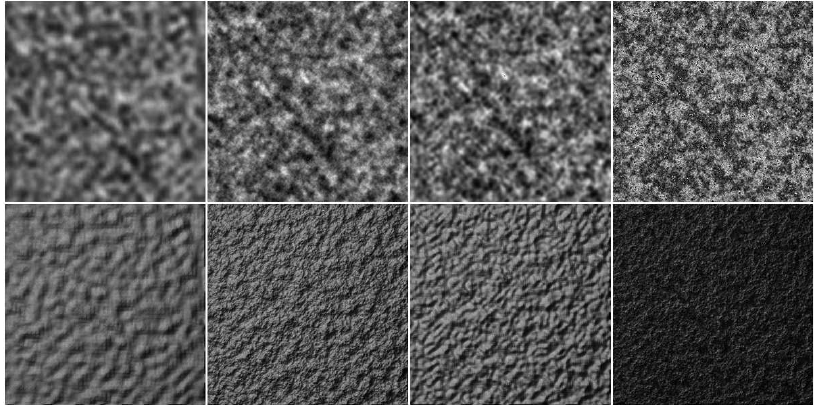
Figure 12. Textures generated with Perlin noise. First, row: height maps. Second row: relighting